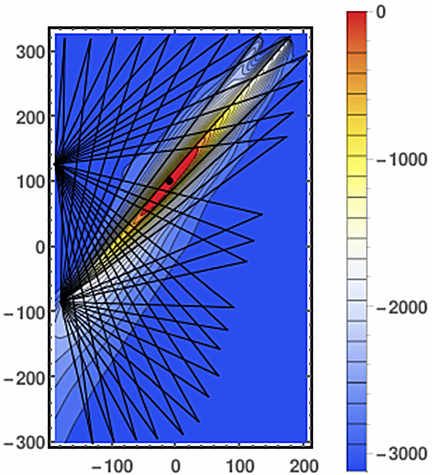
Figure 3. Contour plot of log likelihood for a source at ( − 10.30, 99.25)m with Q = 10 5 µmolmol − 1 m 3 s − 1 at a height z 0 = 10m with x , y positions as in Fig. 1. In this figure, the log likelihood is referenced to that of the known true position. The maximum is shown with a black dot. The light paths are also